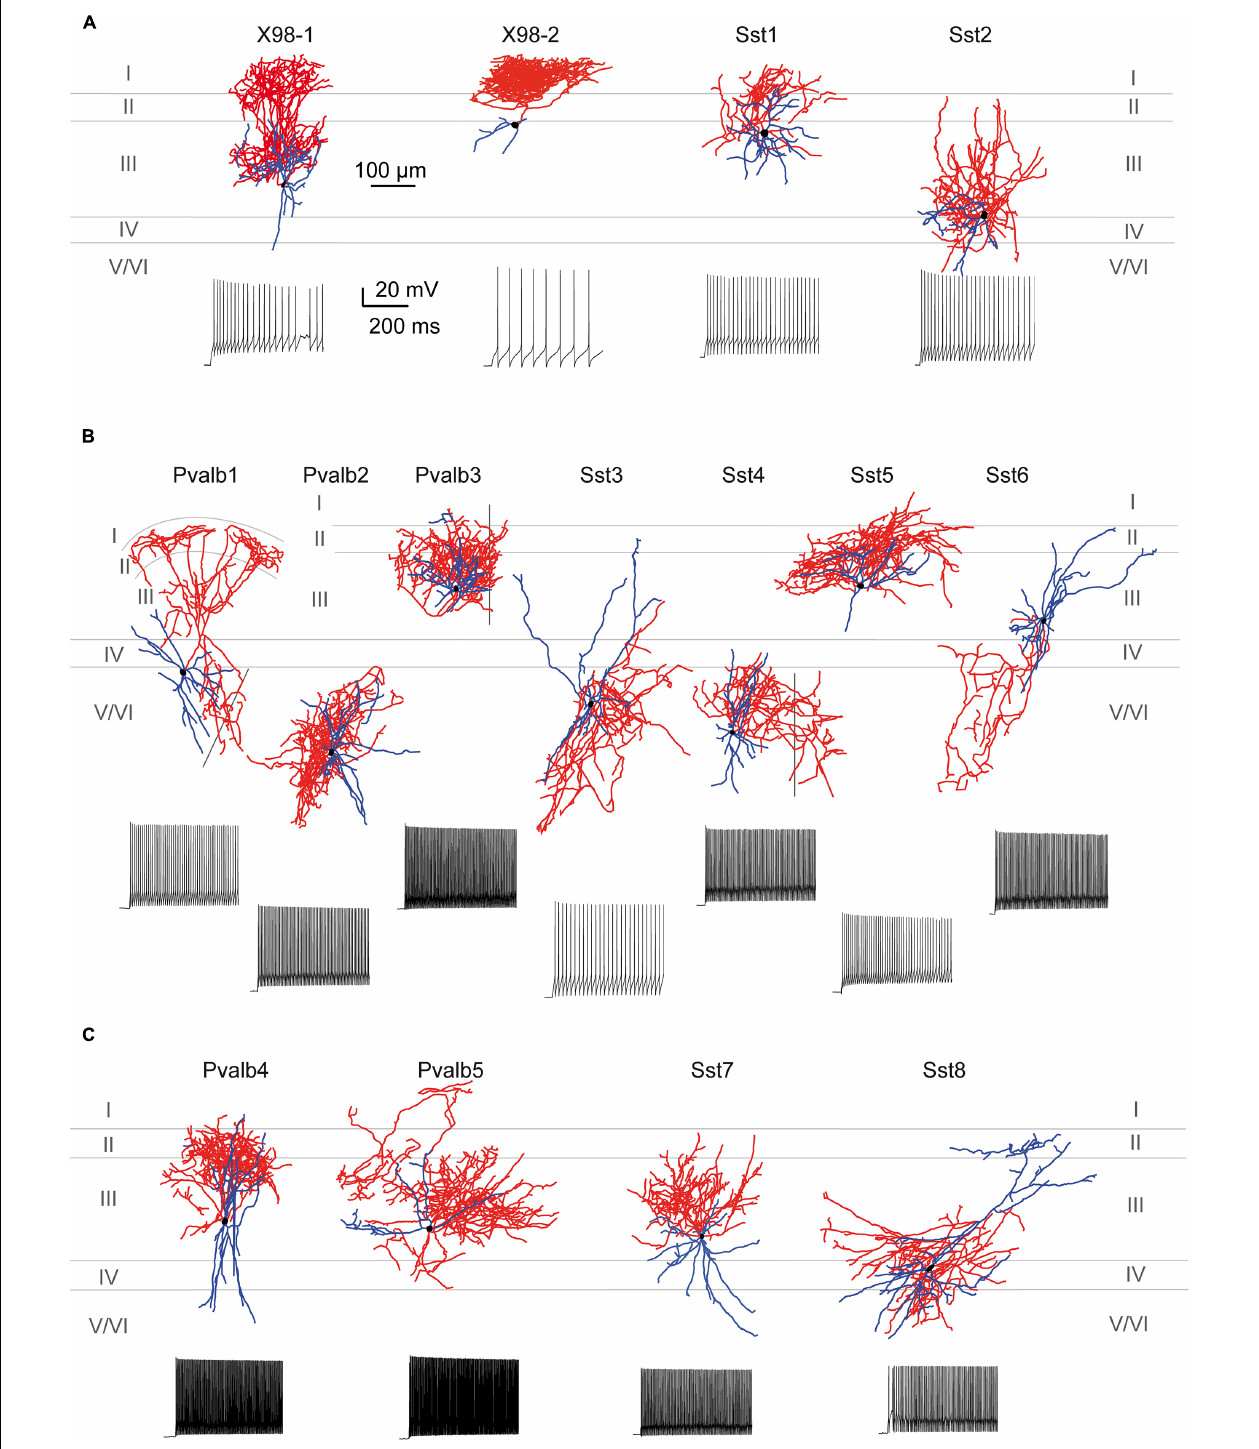
FIGURE 7 | Morphological variability of presubicular interneurons and firing patterns. (A–C) Axo-dendritic arbors of 15 biocytin-filled, reconstructed interneurons typical for clusters 1, 2, and 3. Neurons were recorded from the X98, Sst-Cre or Pvalb-Cre mouse lines as indicated. Axons are shown in red, dendrites in blue and cell bodies in black. Firing patterns are shown for each neuron for a double rheobase current injection. (A) Cluster 1 comprised putative